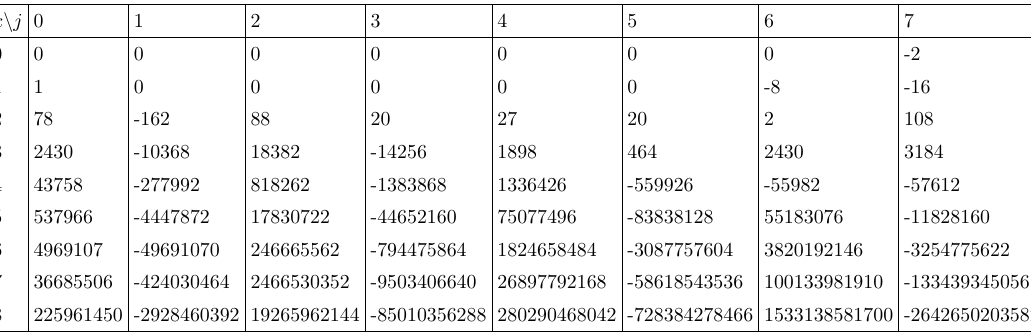
Table 72. Table of b jk coe(cid:14)cients for h E 6